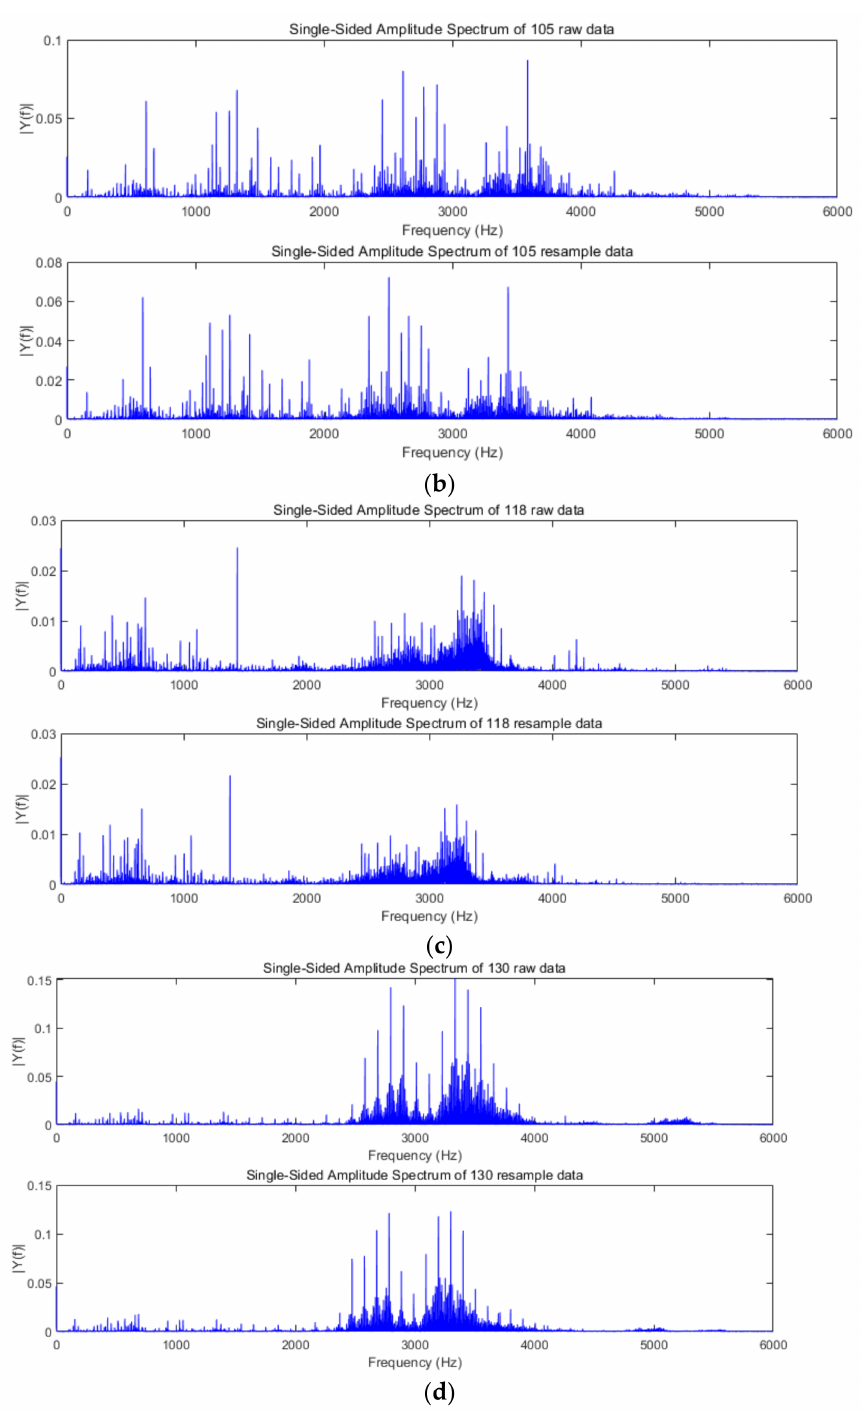
Figure 8. The spectral characteristics of raw data and resampling data. ( a ) Spectrum of vibration data in healthy state; ( b ) spectrum of vibration data in inner race fault state; ( c ) spectrum of vibration data in ball fault state; ( d ) spectrum of vibration data in outer race fault